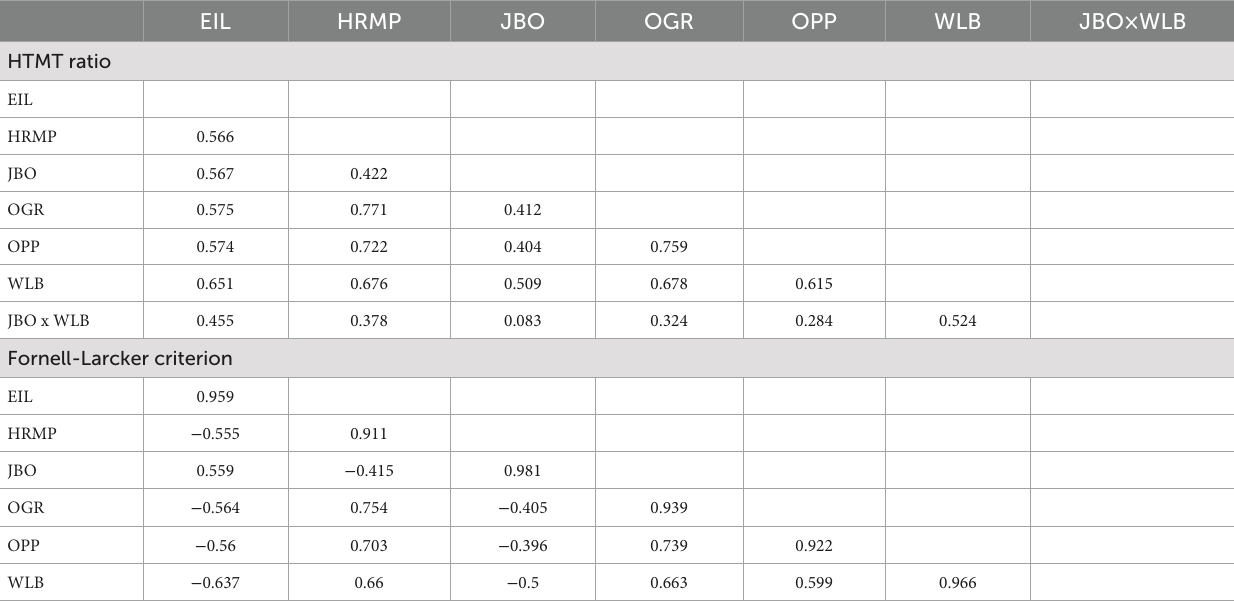
TABLE 3 Discriminant Validities.